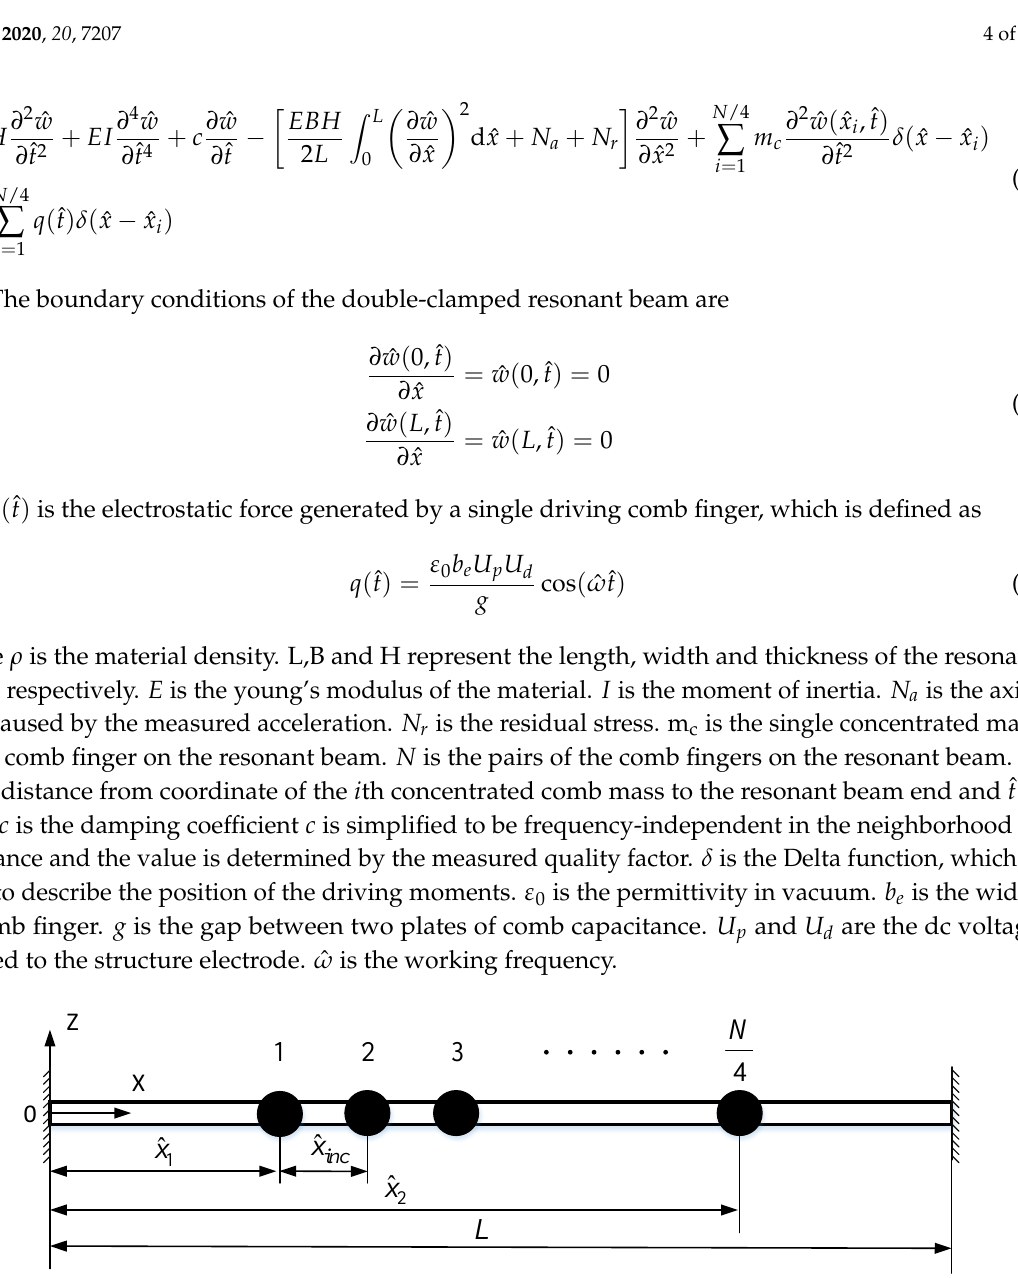
Figure 2. Equivalent mechanical model of resonant beam with comb